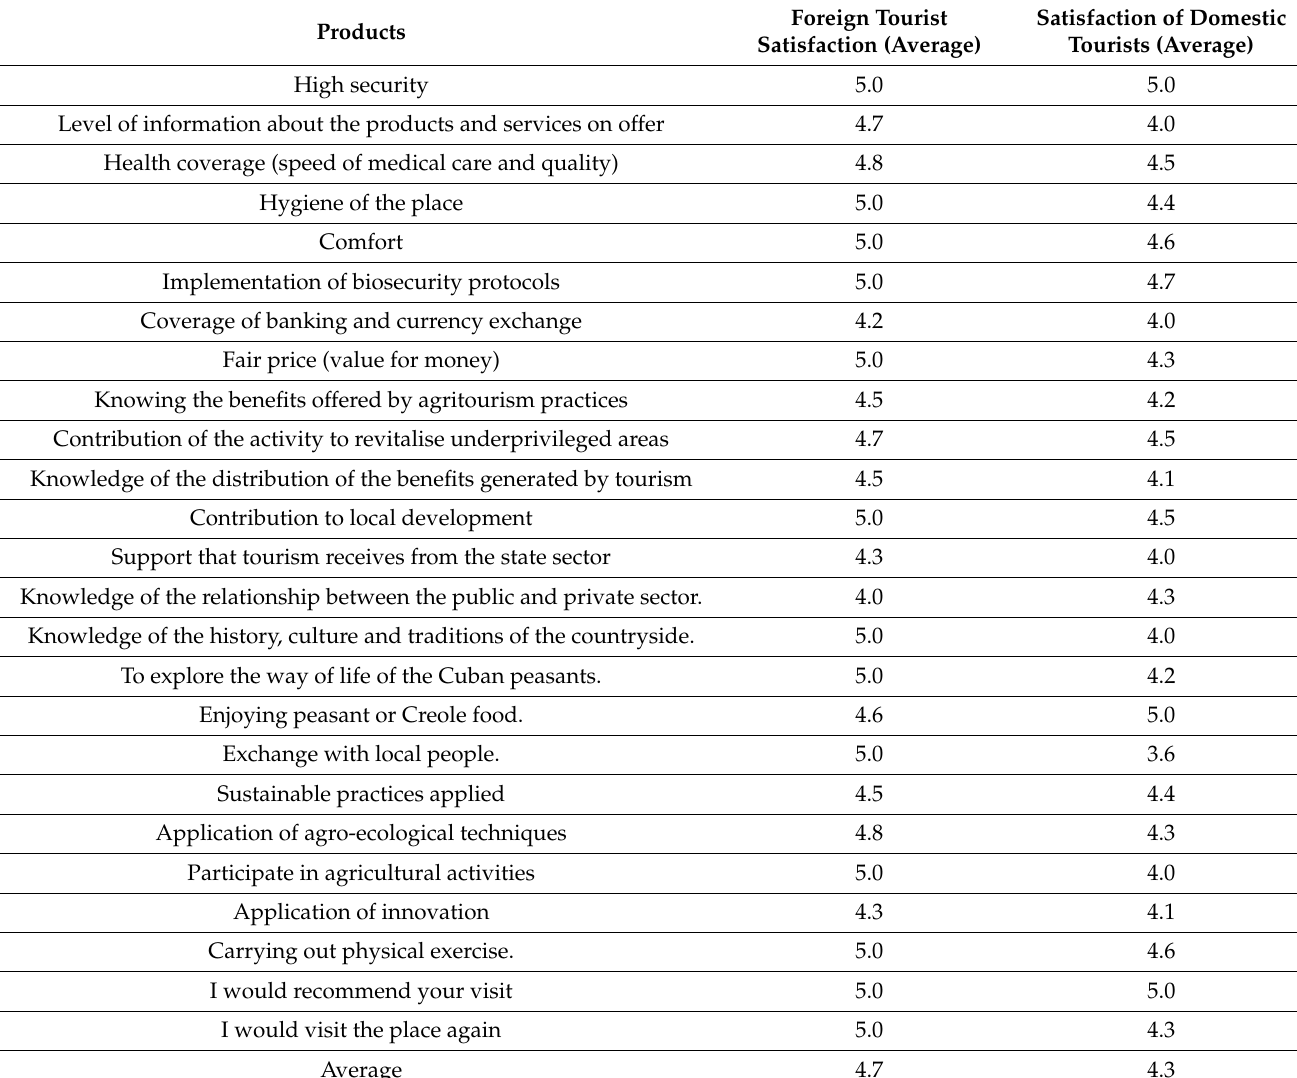
Table 4. Level of perception of tourists regarding their preferences for the selection of the agrotourism product. Differences between foreign tourists and domestic